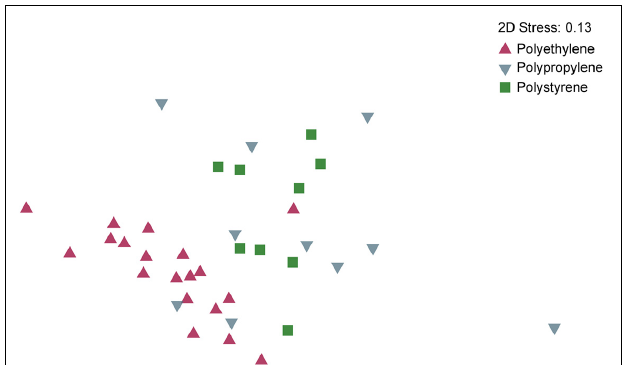
FIGURE 4 | Non-metric multidimensional scaling (NMDS) of microbial communities on OTU level based on 16S rRNA gene sequencing from biofilms colonizing polyethylene, polystyrene, and polypropylene plastic polymers. nMDS on order level yielded similar results ( Supplementary Table 1 ).